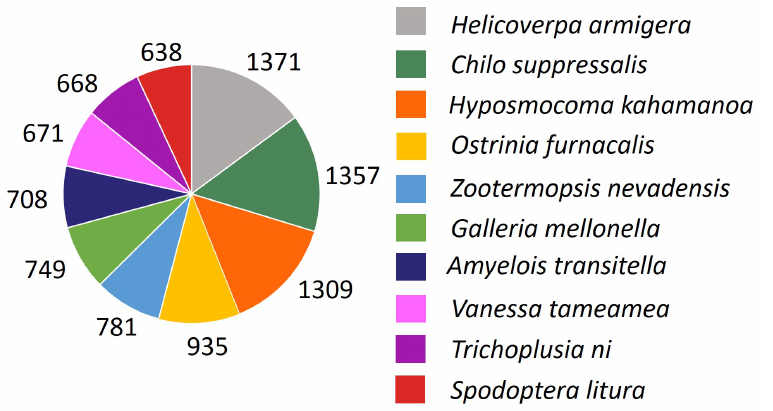
Figure 3. Species distribution of the BLASTX results. Note: This figure shows the top 10 species distribution of transcripts BLASTX results against the SwissProt and NCBI-NR protein database with a cut-off E value 10-3. Different colours represent different species.